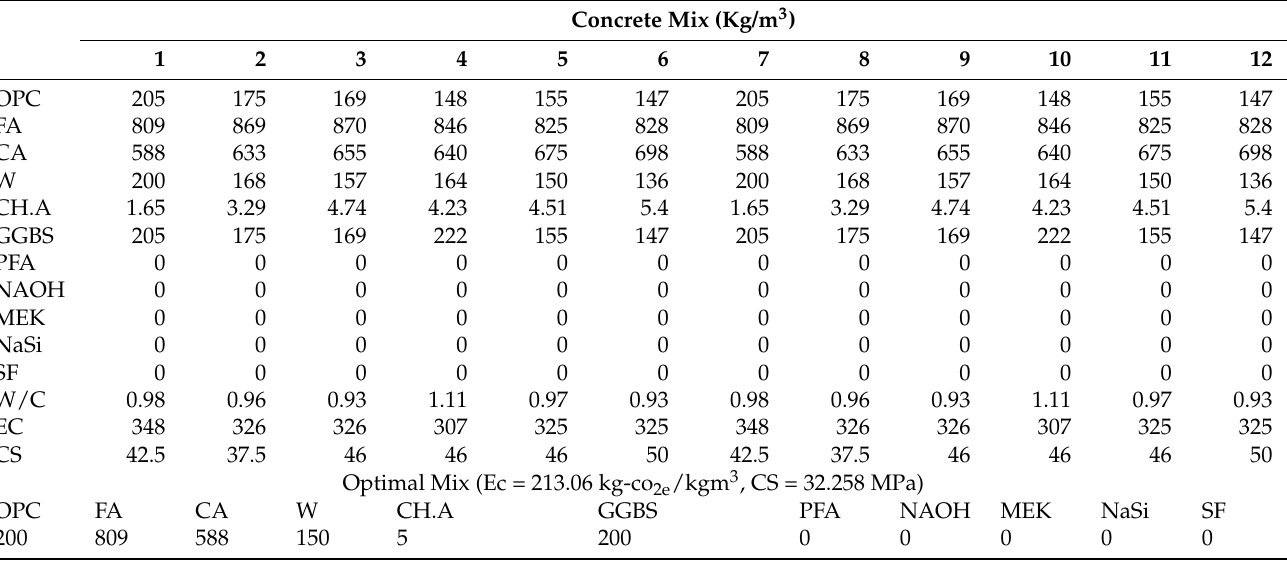
Table 11. Concrete mix optimisation extracted from [22].